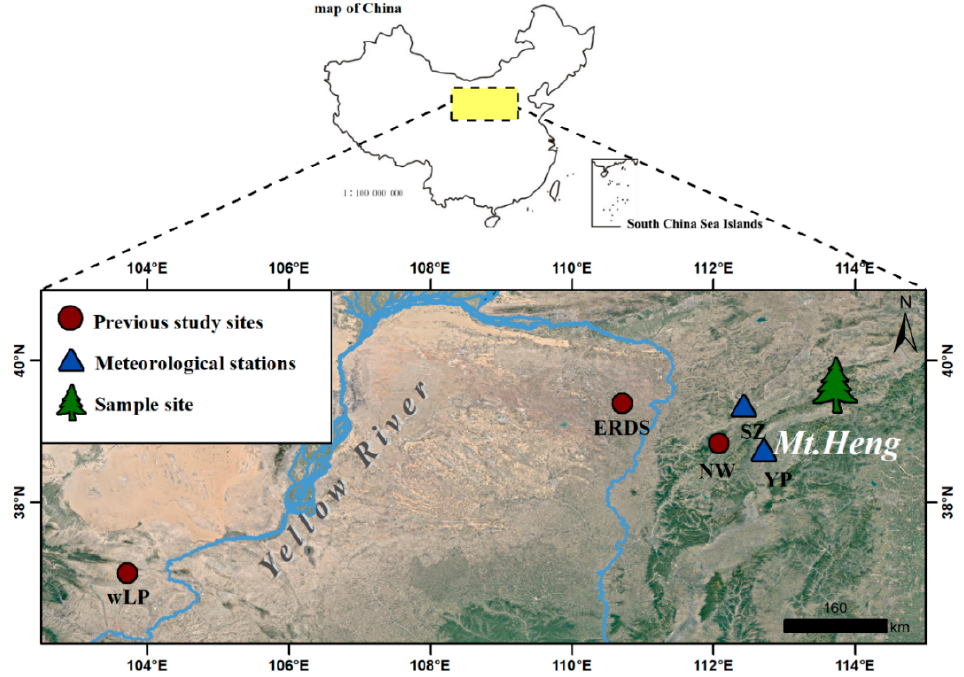
Figure 1. Sampling site, meteorological stations and previous study sites used for comparisons in this paper [6,11,15].